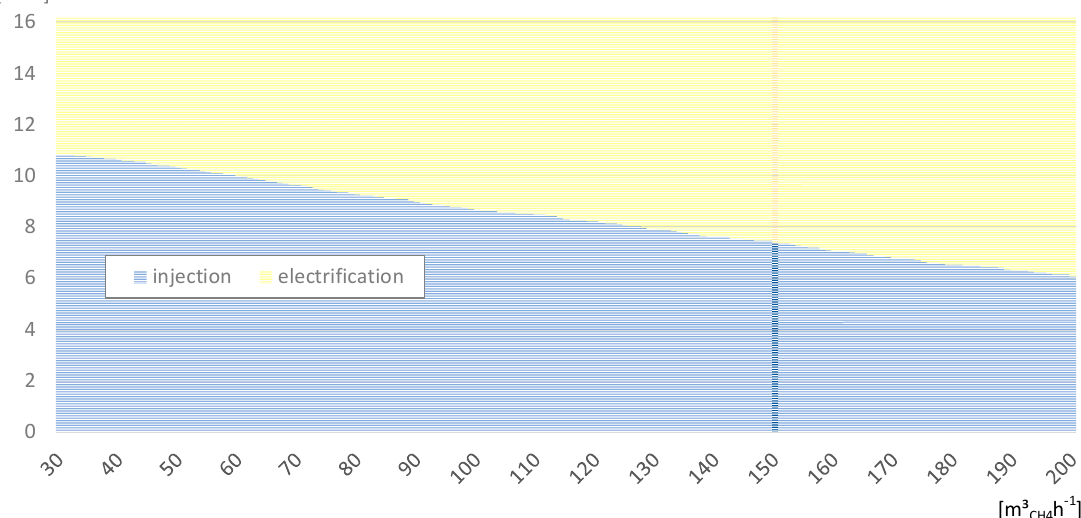
Figure 5. Change in biomethane injection potential based on changes in the minimum feed-in capacity (own analysis).